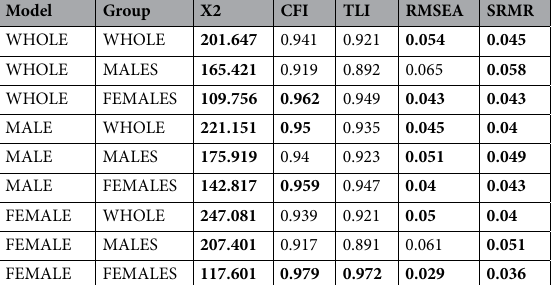
Table 2. Model fit indices for male and female refined models applied to the different groups. Values in bold reach the threshold for being an excellent